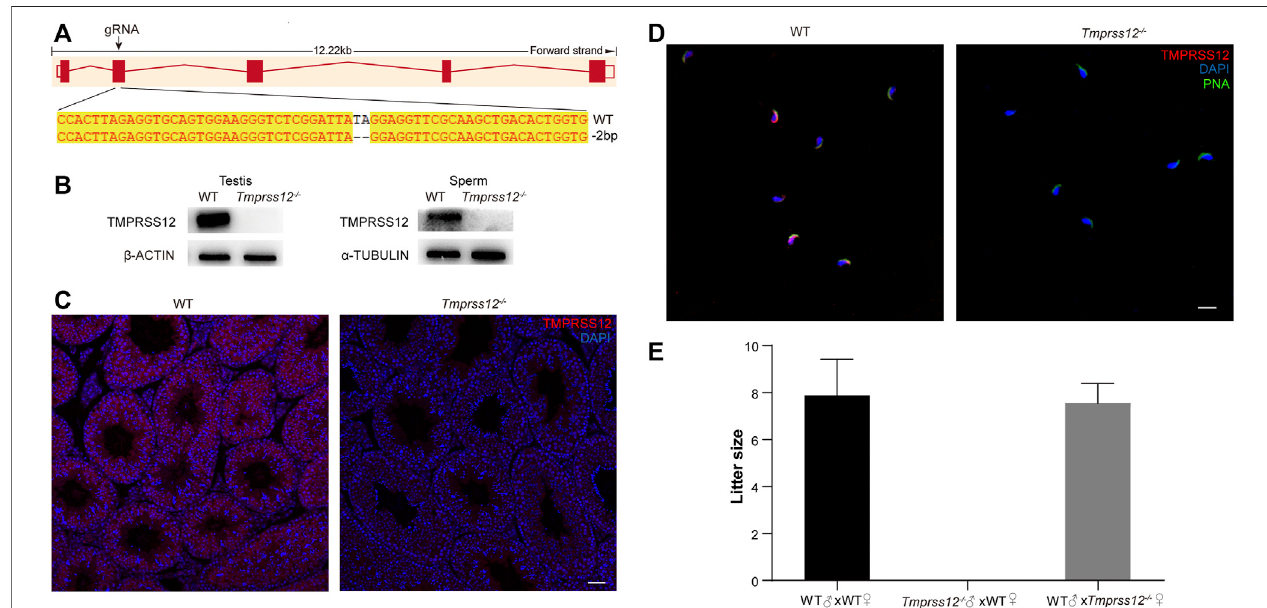
FIGURE 2 | Tmprss12 knockout mice display male sterility. (A) Schematic strategies for the generation of Tmprss12 − / − mice using CRISPR/Cas9 technology. ImageofSangersequencingresultsshowinga2-bpdeletioninexon2. (B) WesternblotofthetestesandspermfromWTand Tmprss12 − / − micetoverifythevalidationof Tmprss12 knockout. β -ACTIN and α -TUBULIN were used as internal controls. (C) TMPRSS12 expression in the testes of WT and Tmprss12 − / − mice was evaluated throughimmuno fl uorescenceanalysis.NoTMPRSS12signalwasdetectedin Tmprss12 − / − mice.Scalebar:50 µm. (D) TMPRSS12expressioninthespermofWT and Tmprss12 − / − mice was determined by immuno fl uorescence analysis. A positive signal was not observed in Tmprss12 − / − sperm. Scale bar: 20 µm. (E) Number of pups per litter produced by Tmprss12 − / − mice and WT mice. Tmprss12 − / − male mice are infertile ( n = 3). Data are the mean ±